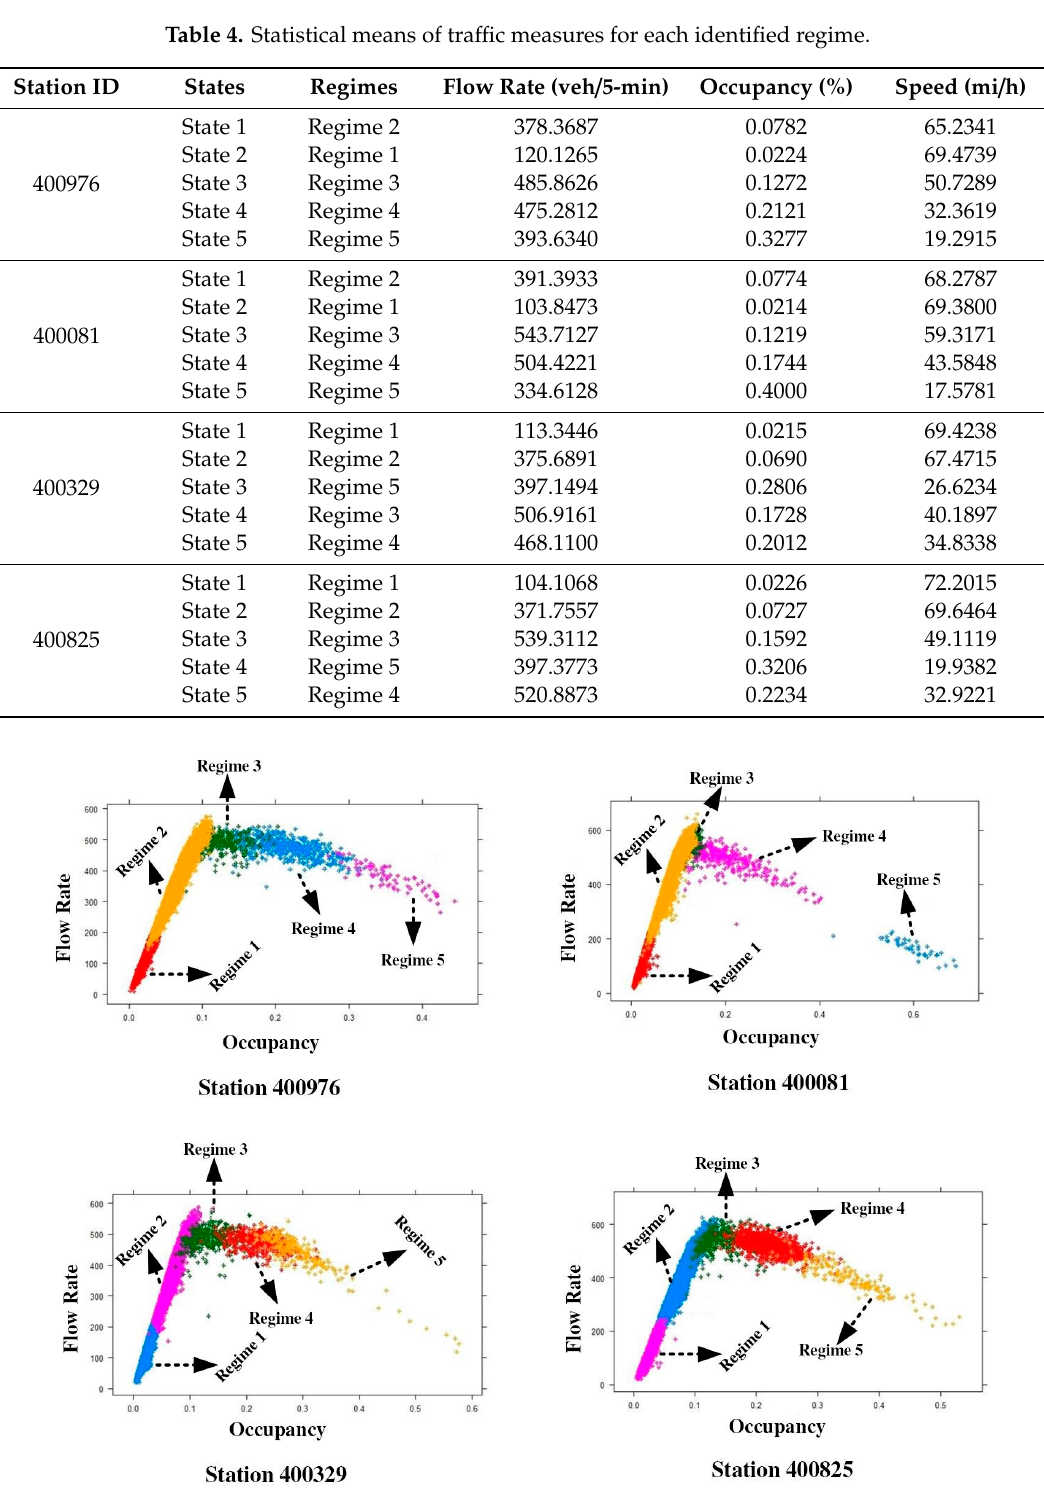
Figure 4. Regime identification results associated with the four study stations.